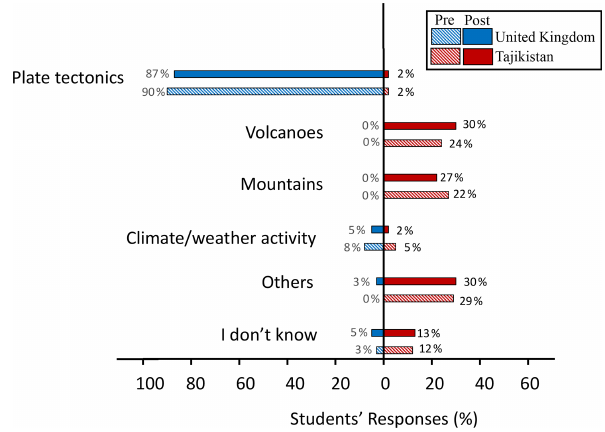
Figure 5. The causes of earthquakes, according to the